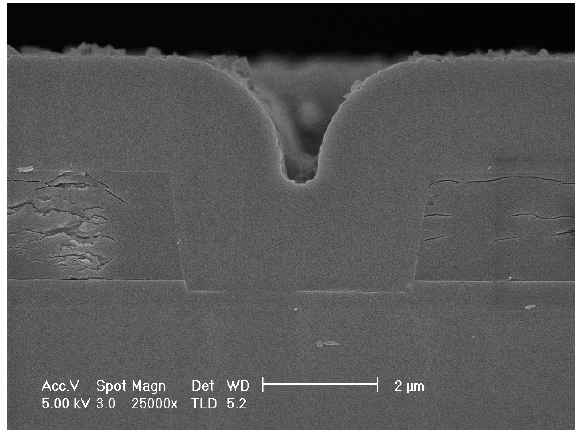
Figure 2. The SEM photograph of cross-section of specimen.